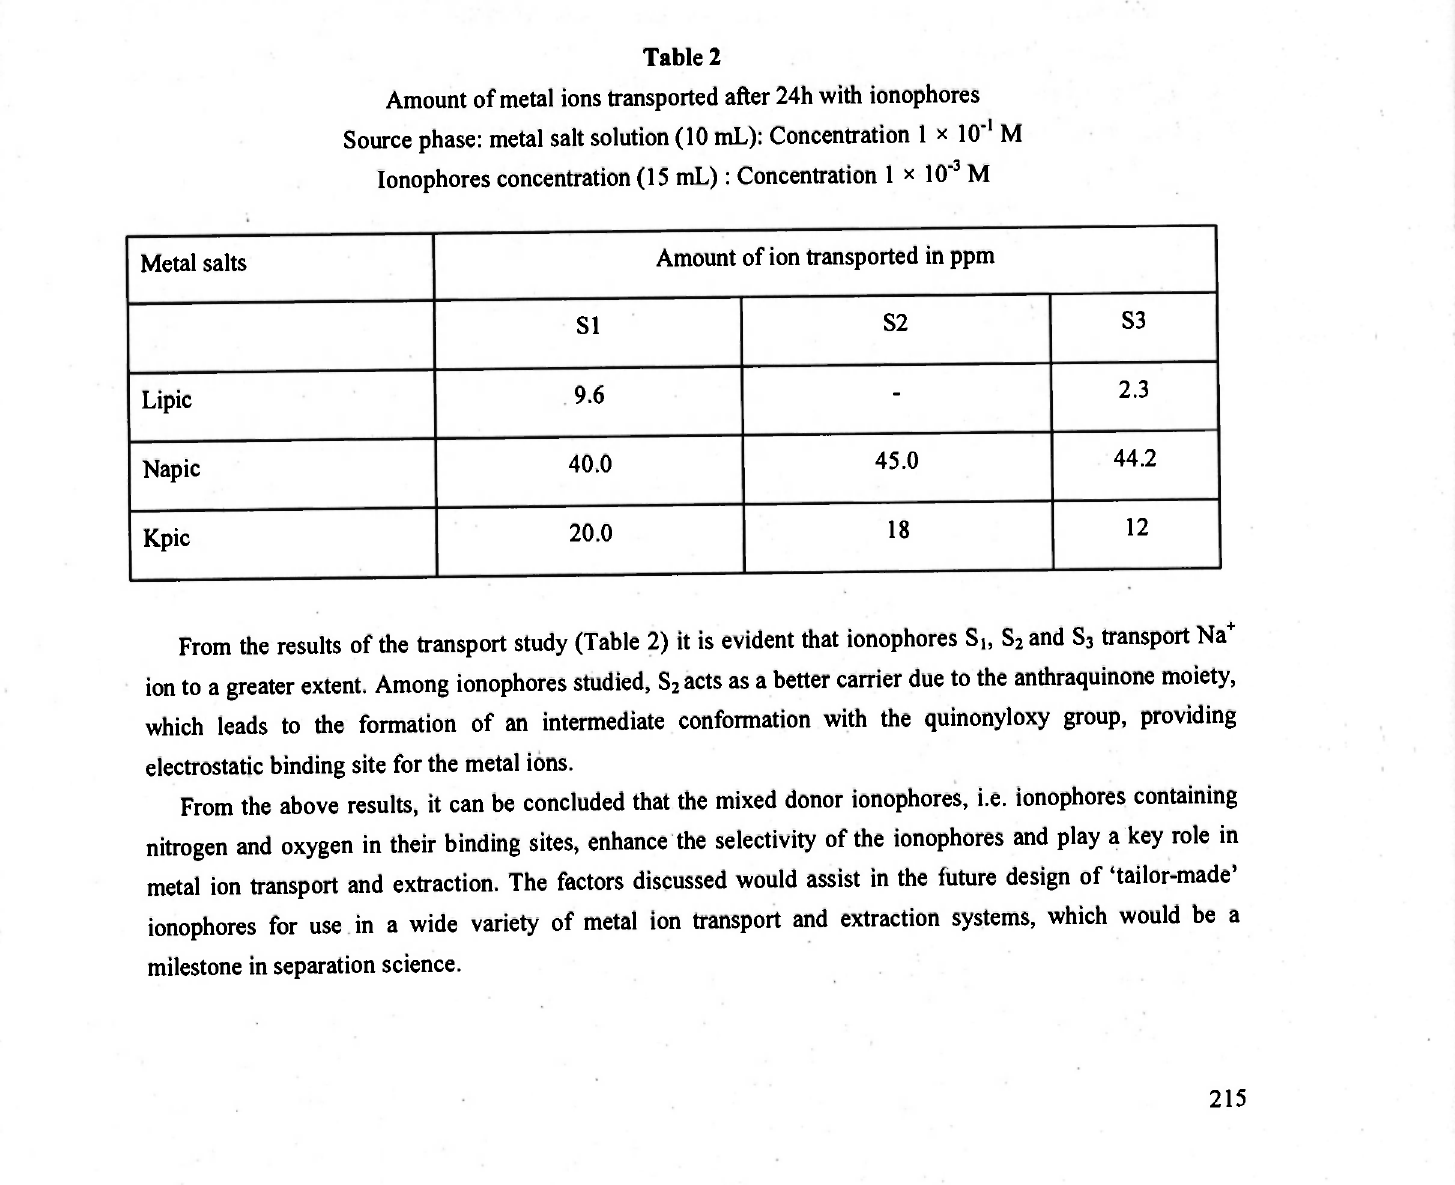
Amount of metal ions transported after 24h with